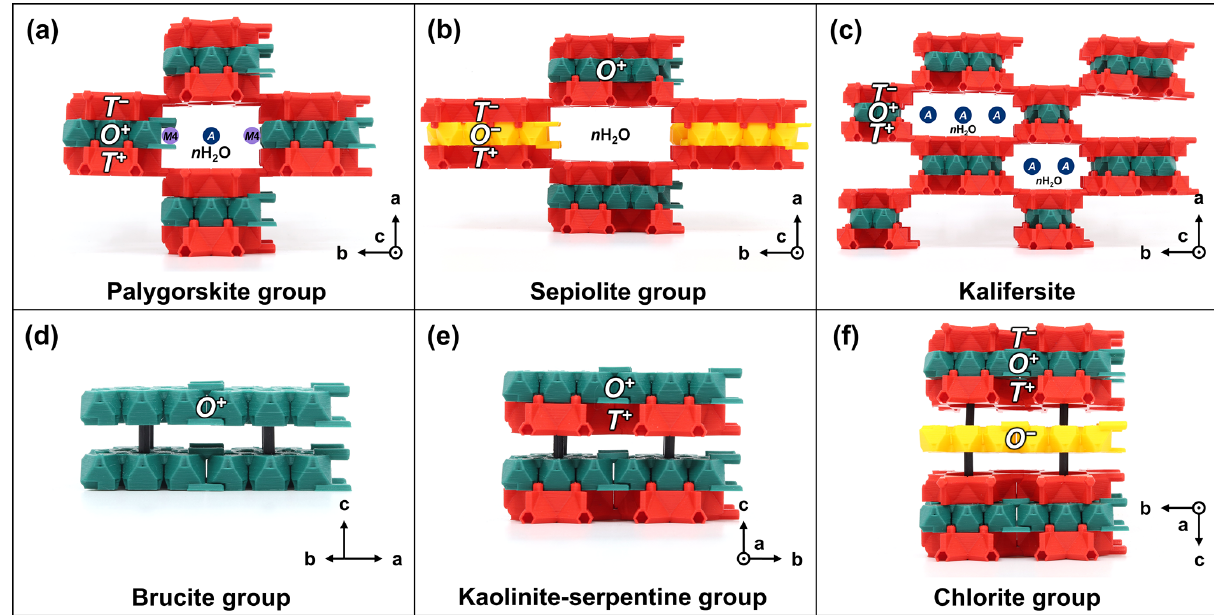
Figure 7. TotBlocks representations of the palysepiole series and other layered minerals: (a) palygorskite group (e.g., Leung and McDonald, 2020), (b) sepiolite group (e.g., Post et al., 2007), (c) kalifersite (Ferraris et al., 1998), (d) brucite group (e.g., Nagai et al., 2000), (e) lizardite (kaolinite–serpentine group; Mellini, 1982), and (f) chlorite group (Zanazzi et al., 2007). Additional sites are denoted by labelled circles (see main text). Black pegs are structural supports intended to hold individual layers; see Fig.